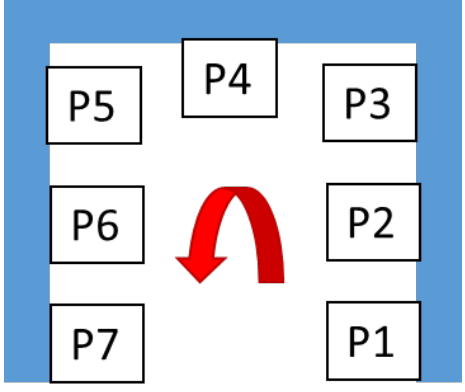
Figure 10. The layout of the positions in the Alpha workstation.